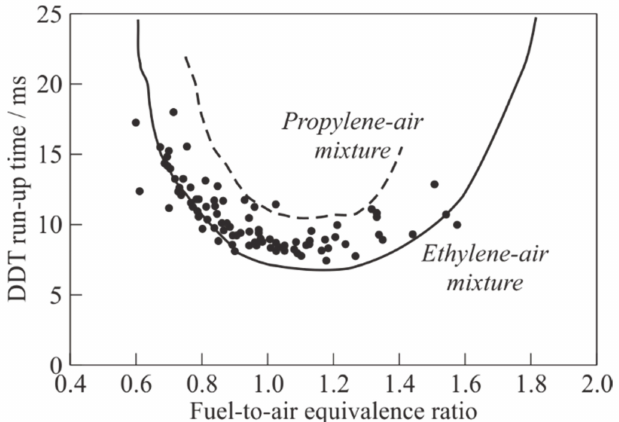
Figure 11. The cumulative dependence of the DDT run-up time on the fuel-to-air equivalence ratio for pyrogas–air mixtures; solid curve is the DDT run-up time for premixed ethylene–air mixtures [25]; dashed curve is the DDT run-up time for premixed propylene–air mixtures